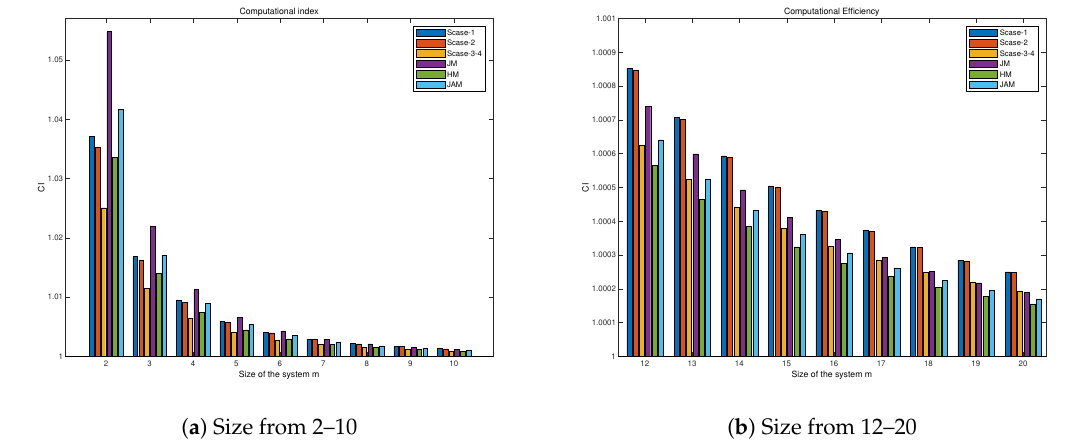
Figure 1. Index CI for different sizes of the